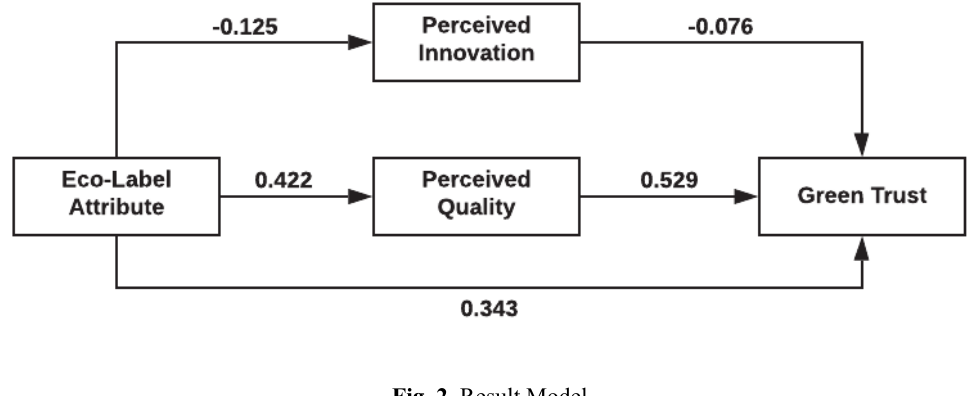
Fig. 2. Result Model